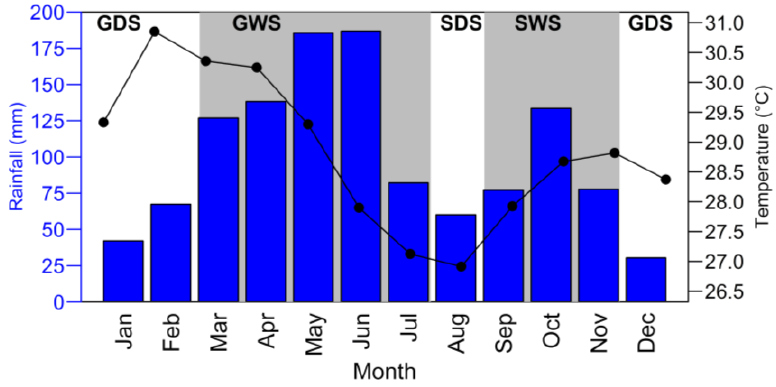
Figure 2. Precipitation–temperature diagram over 2014–2017. GDS, GWS, SDS, and SWS are respectively the Great Dry Season, the Great Wet Season, the Short Dry Season and the S hort-Wet S eason .